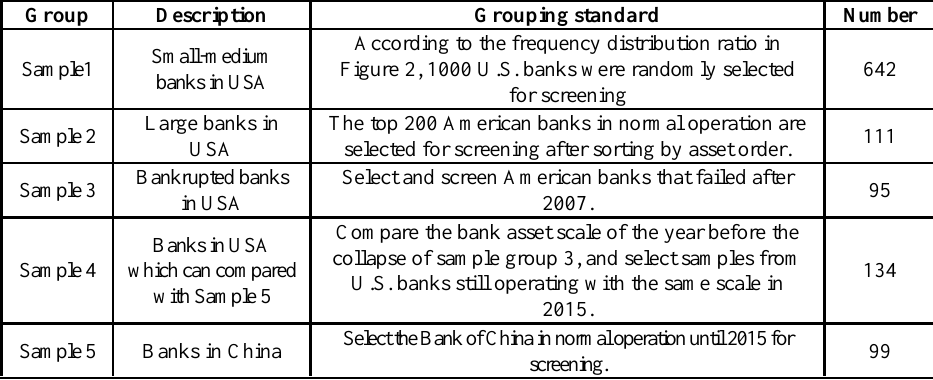
Table 1. Sample grouping